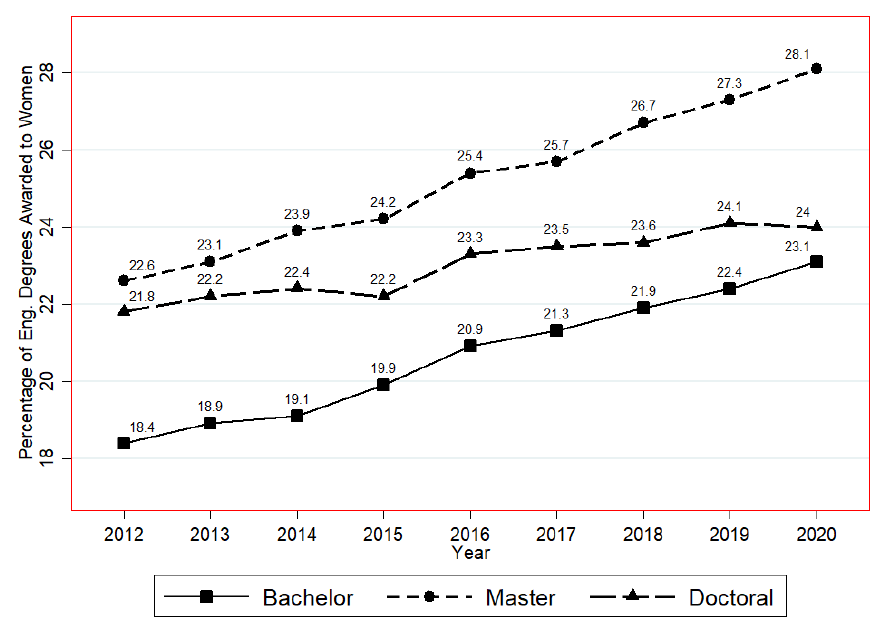
Figure 1. Percentage of bachelor, master, and doctoral degrees awarded to women in engineering and engineering technology in the USA (2012–2020) [11].